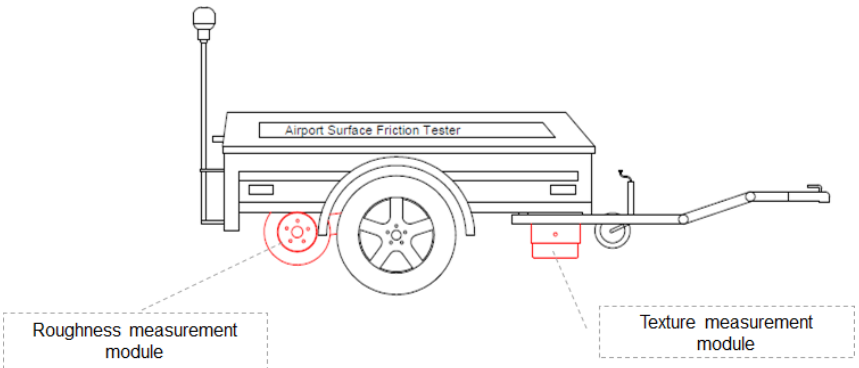
Figure 1. Scheme of measurement system for anti-skid properties assessment. Roughness evaluation module is the airfield pavement friction tester on trailer T-10 manufactured by ASFT (Ystad, Sweden) (Figure 2).